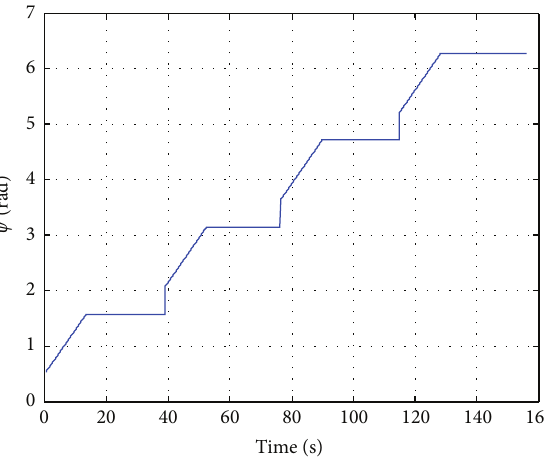
Figure 16: Smooth psi angle reference.